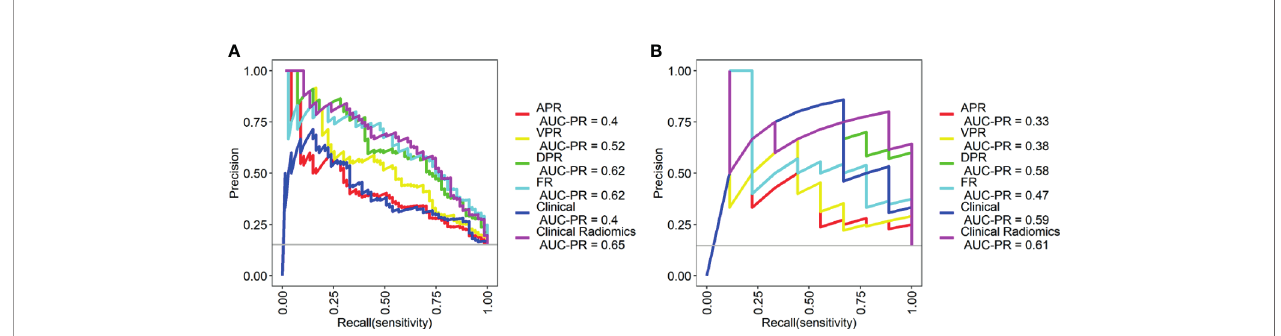
FIGURE 5 | Precision-recall (PR) curves of the different models in the training cohort (A) and validation cohort (B) . PR represents the relationship between precision and recall. The larger the area under the curve value of the PR curve, the better the model performance. Precision = true positive/(true positive + false positive); recall = true positive/(true positive + false negative). APR, radiomics model of arterial phase; DPR, radiomics model of delayed phase; VPR, radiomics model of venous phase; FR, radiomics model of fusion of arterial phase, delayed phase and venous phase features; Clinical Radiomics, fusion of clinical risk factors and radiomics features of delayed phase.